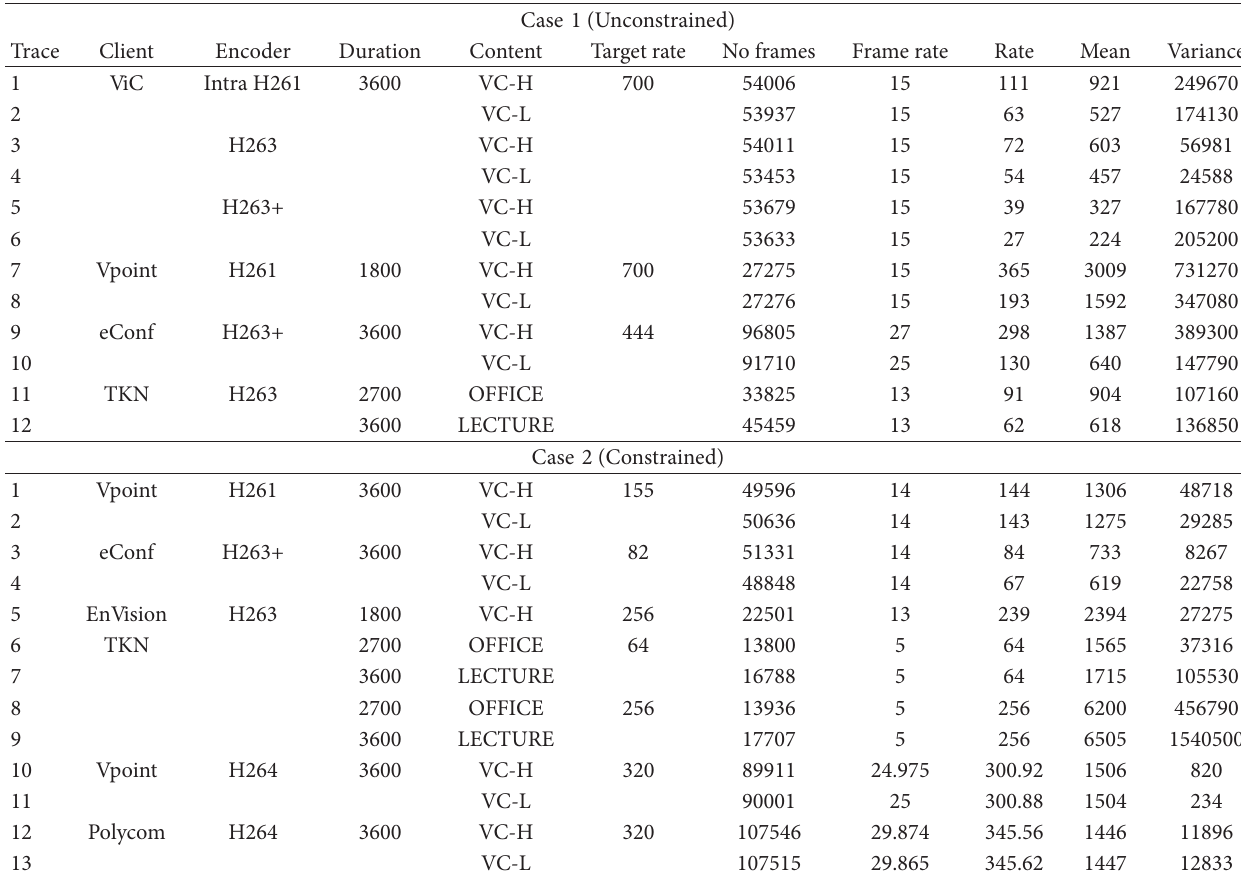
T 1: Statistical quantities of the sample frame-size